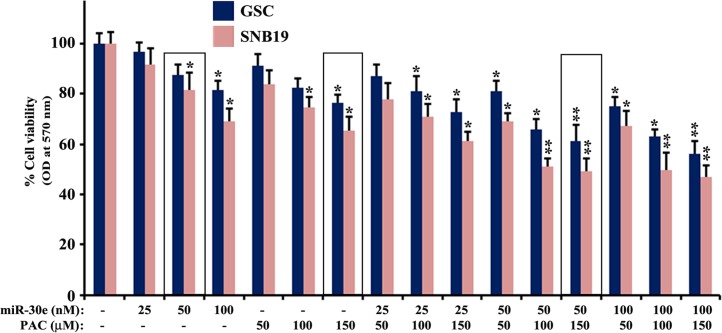
MTT assay to determine the changes in residual cell viability in the 2 mM SS pre-treated GSC and SNB19 cells after transfection with 25, 50, and 100 nM miR-30e for 12 h or treatment with 50, 100, and 150 μM PAC for 24 h, or their combinations.After the treatments and incubation, alterations in cell viability were measured by the MTT assay. All experiments were conducted in triplicates and the results were analyzed for statistical significance. Difference between control (CTL, the untreated group) and a monotherapy or combination therapy was considered significant at *P < 0.05 or **P < 0.01.